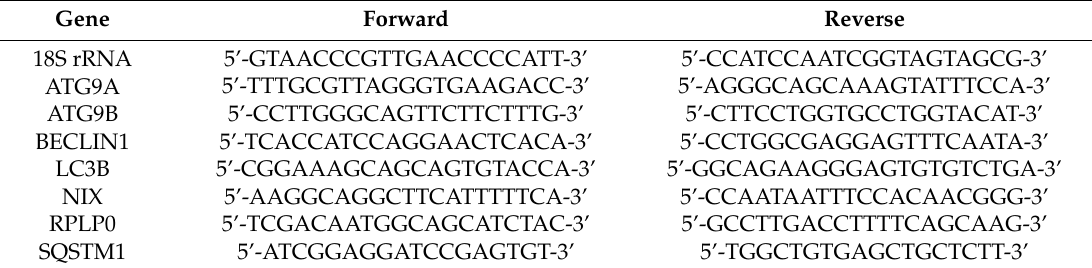
Table 2. Primer sequences used for Syber Green RT-qPCR